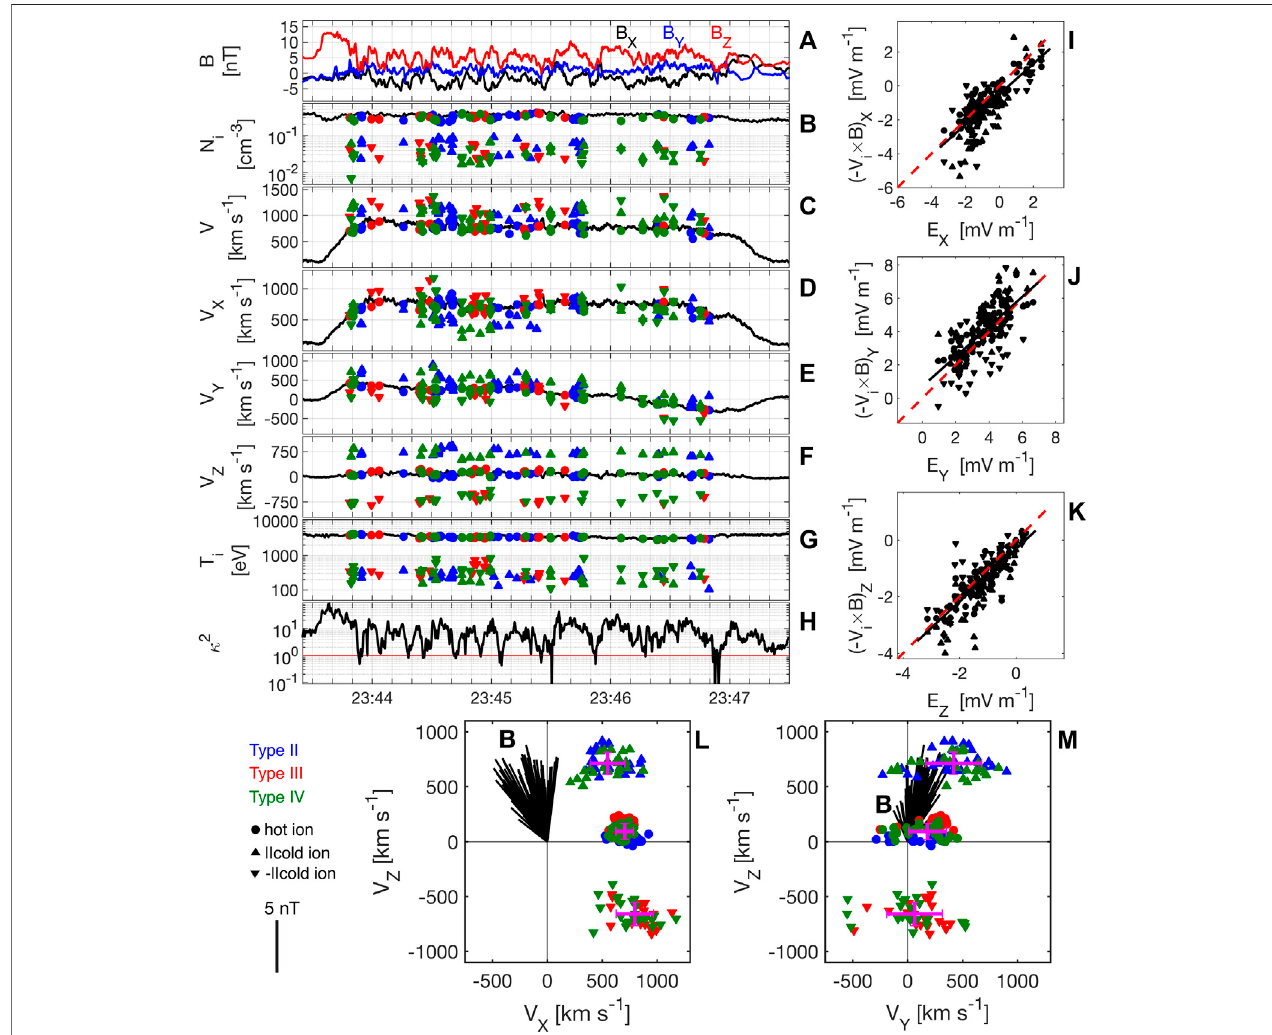
FIGURE 5 | Partial moments of the cold-ion beams and the hot ions inside the earthward ion jet. Those ions are from the three types (Types II, III and IV) with cold ions. Types II, III and IV are colored in blue, red and green, respectively. The partial-moment results of the hot, parallel cold and anti-parallel cold ions are marked by circles,upward-pointingtrianglesanddownward-pointingtriangles,respectively. (A)B . (B) N i ofallions(blackcurve)andcoldandhotionsfrompartialmoments. (C) Ion bulkspeedV. (D) – (F) ThreecomponentsoftheionbulkvelocitiesV i .Theblackcurvesaretheaveragebulkvelocities. (G) T i . (H) Adiabaticparameterde fi nedby κ 2 (cid:2) fi eldcurvatureradius and ρ – (K) Scatterplotsofthemeasured E from R B ρ ci (BüchnerandZelenyi, 1989),whereR B ismagnetic ci isthegyroradius ofthe320 eV coldions. (I) EDP and the convection electric fi eld ( - V i × B) of hot and cold ions from selected data points. The black dashed lines denote slope (cid:2) 1, and the red dashed lines are the linear fi tsofthepartial-momentresults. (L) – (M) Scatterplotsoftheionbulkvelocityoftheselectedpoints.Thecrossespresenttheaveragesandthestandarddeviations, and the black lines show the normalized magnetic fi elds.